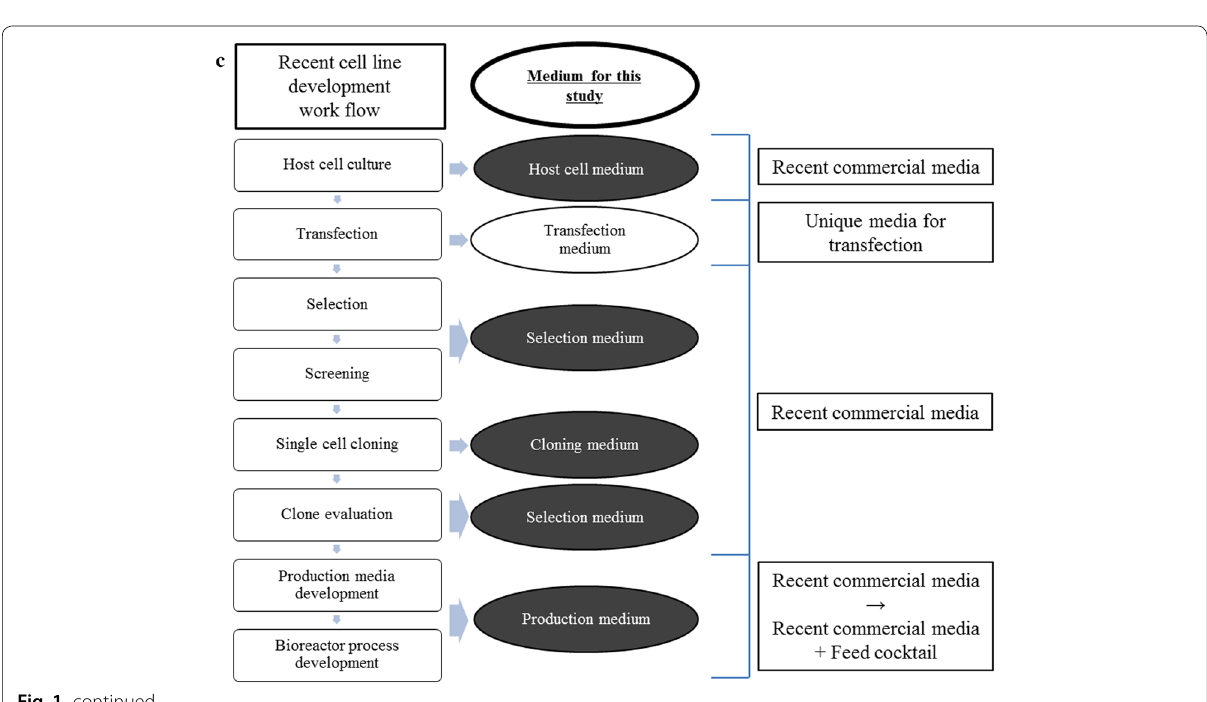
Fig. 1 Typical cell line development (CLD) workflow change following media development ( a ) traditional CLD using classical media (with serum) during cell line screening and then adapting to (serum-free) commercial media, (( b ) recent CLD changes by adapting host cells to commercial media and using throughout the CLD process, however transfection and cloning requires a unique media, while production will mostly require a rich production media (recent commercial media) to achieve higher productivities, c our intended CLD method in this study which uses a rich